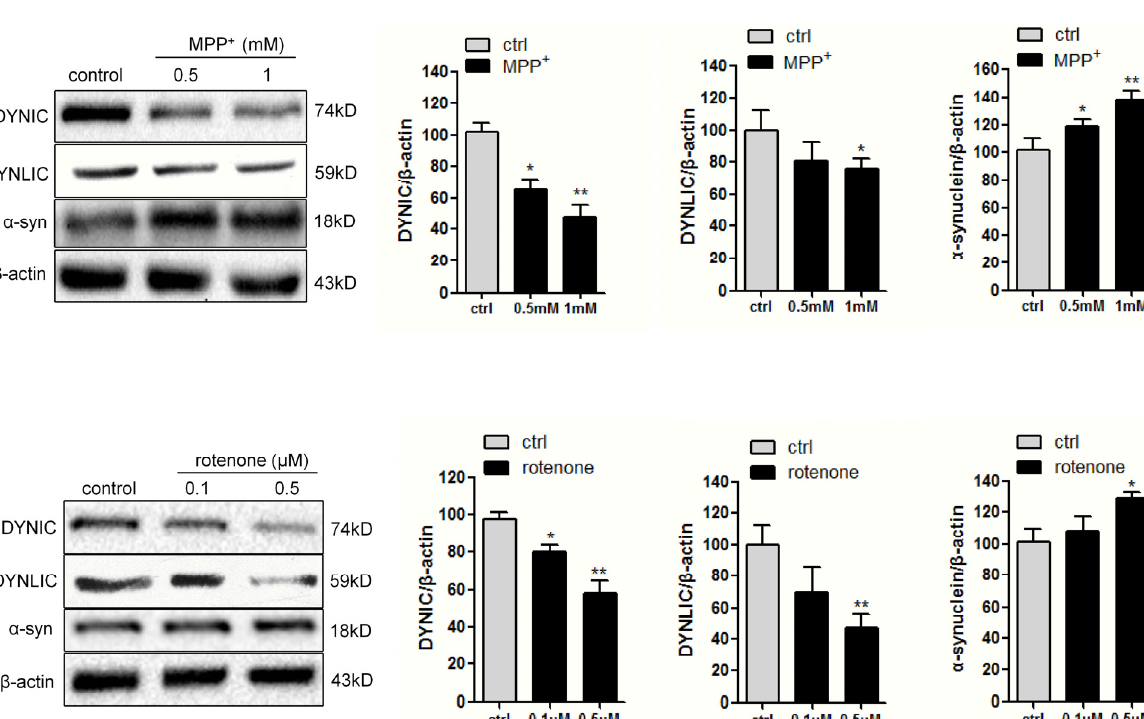
Figure 1. Neurotoxin-induced a decrease of dynein chains but increase of α -synuclein in PC12 cells. Cells were treated with 0.5 or 1 mM 1-methyl-4-phenylpyridinium (MPP + ) ( A ); 0.1 or 0.5 µM rotenone ( B ) or vehicle for 24 h. 20 μ g proteins were analyzed for dynein intermediate chain (DYNIC), dynein light intermediate chain (DYNLIC) and α -synuclein immunoreactivity with β -actin as loading controls. Data are expressed as mean ± SEM, n = 3. * p < 0.05; ** p < 0.01 versus